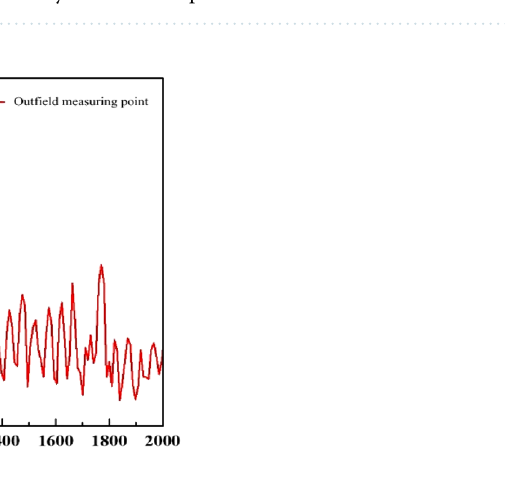
Figure 19. Directivity distribution of outfield noise by the surface dipole.